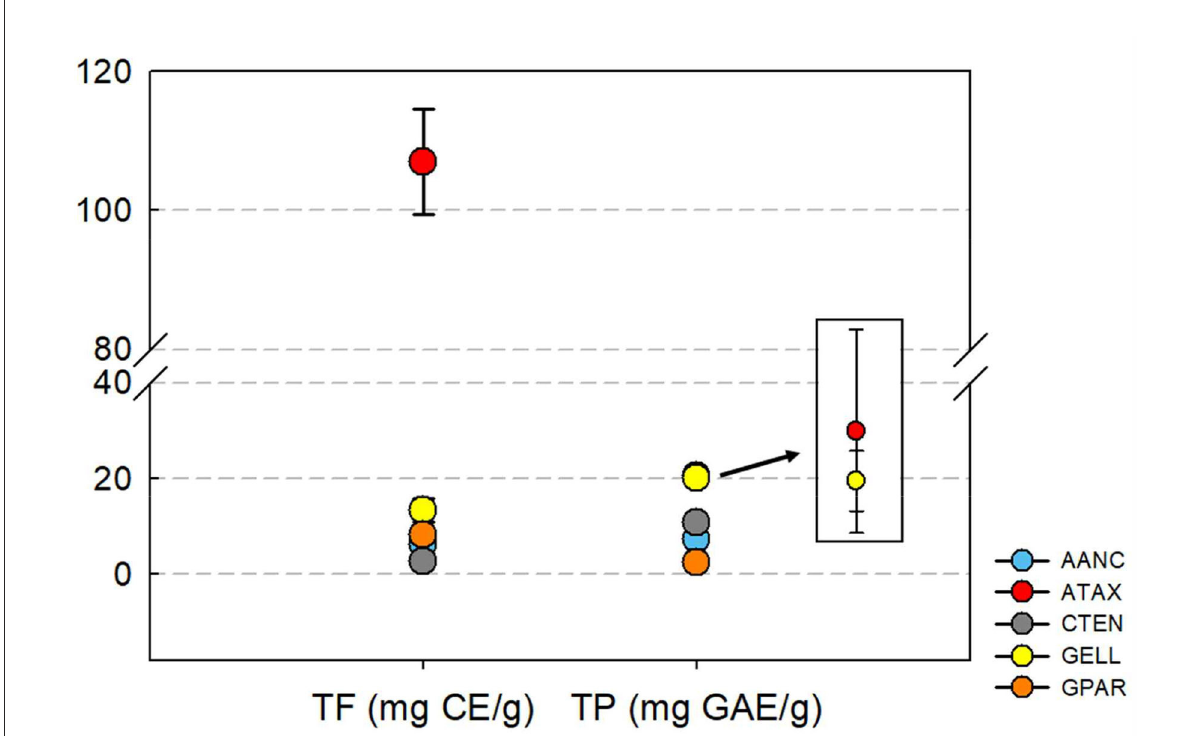
FIGURE1 Concentration of total flavonoid and polyphenol in red seaweed extracts. TF, total flavonoid; CE, Catechin equivalent; TP, total polyphenol; GAE, garlic acid equivalent; AANC, Amphiroa anceps ; ATAX, Asparagopsis taxiformis ; CTEN, Chondracanthus tenellus ; GELL, Grateloupia elliptica ; GPAR, Gracilaria parvispora . Bars represent standard error of triplicate analysis.